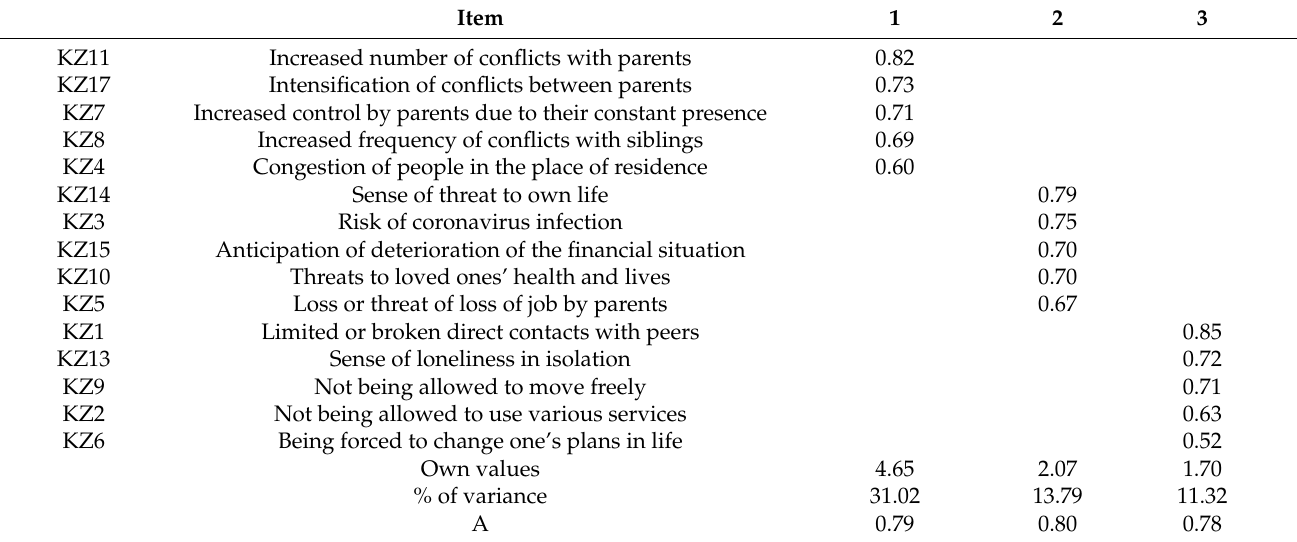
Table 1. Factor structure of the Pandemic Threat Assessment Questionnaire (PTAQ). Rotated factorial loads (Varimax